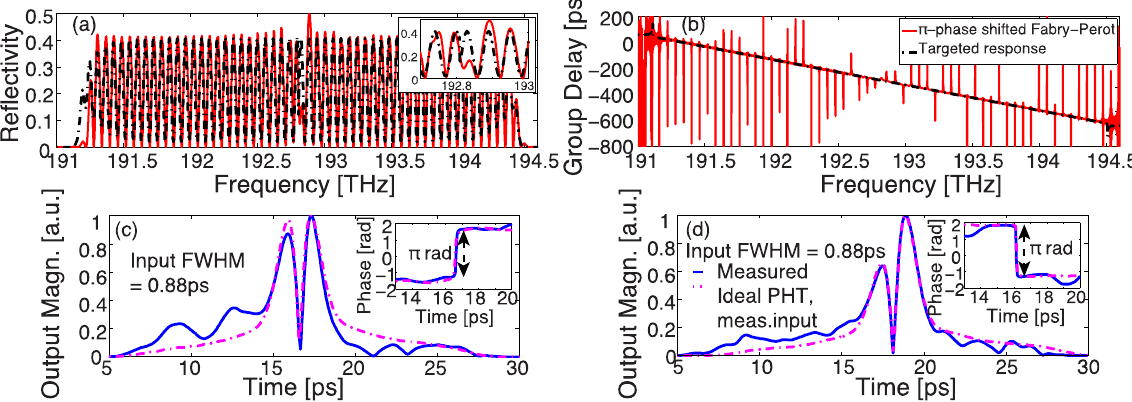
Figure 10. PHT implemented in an FBG in transmission: Comparison between the specified reflectivity ( a ) and group delay ( b ) (in dashed black line) and the experimentally implemented structure (in solid red). Comparison between the experimentally obtained output component of the fabricated integer ( c ) and fractional ( d ) PHTs (solid blue line) and the ideal output (dashed pink line) for an input Gaussian pulse with 0.88 ps-FWHM.